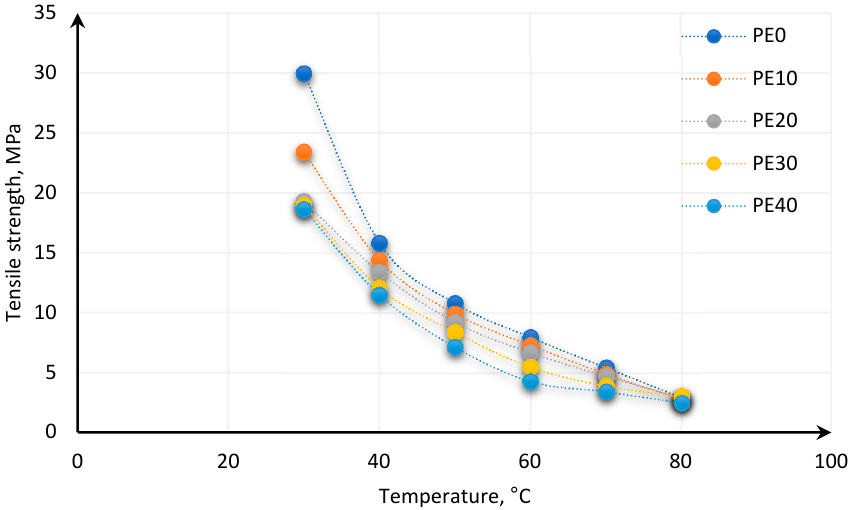
Figure 14. Dependence of tensile strength on disturbed temperature d(T) for different shares of Polyethylene (PE) in butyl rubber-based carbon black-reinforced elastomers. Graph created based on data shown in [131].